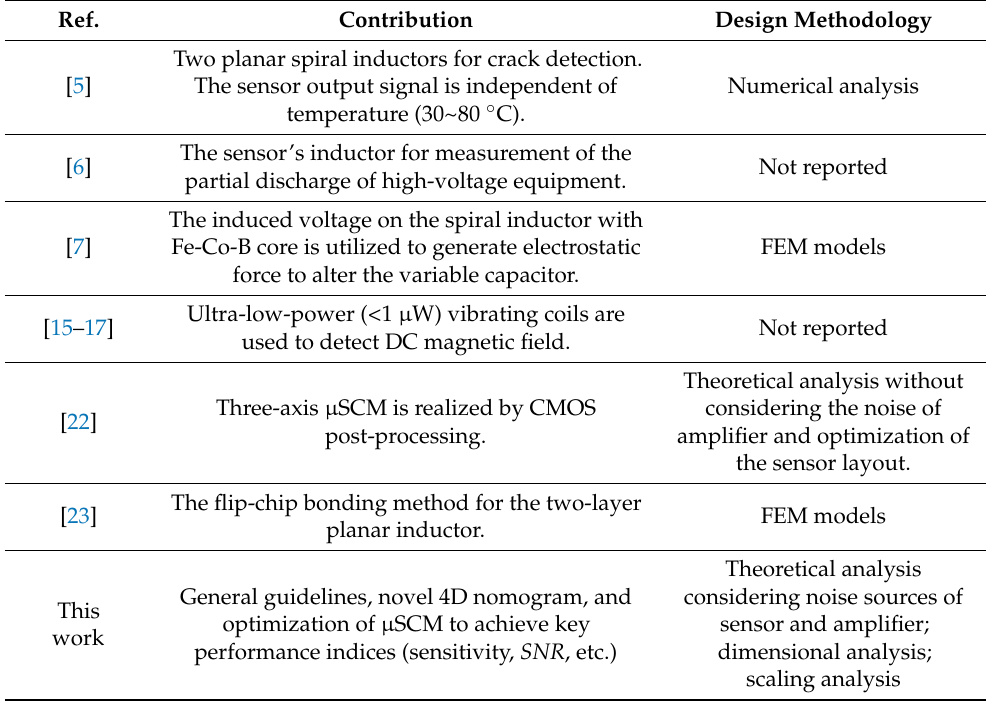
Table 1. The summary of the reported works for several µ SCMs, their contributions, and design methods.